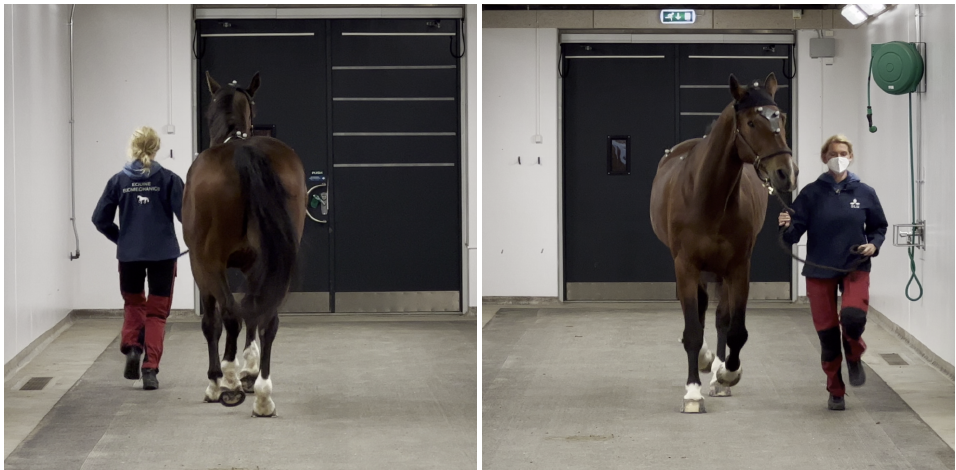
Figure 2. Example images from data set (horse 21) taken from the video recorded by the markerless single-camera system (SC). Attached to the horse’s skin by double adhesive tape are the spherical reflective markers used by the multi-camera marker-based system (MC) for tracking head and pelvic motion. The markers on the poll and between the tubera sacrale were